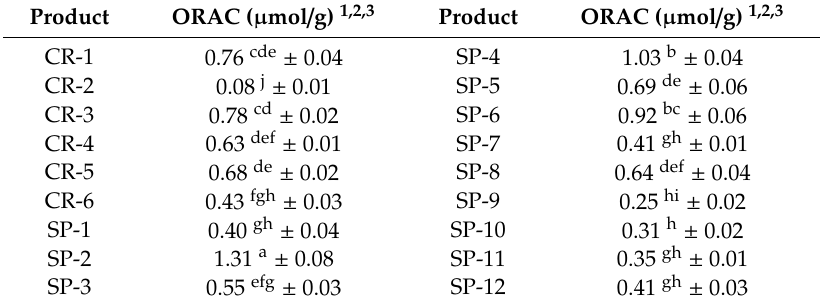
Table 7. Oxygen Radical Absorbance Capacity (ORAC) antioxidant activity of extracts from U. tomentosa bark commercial products.